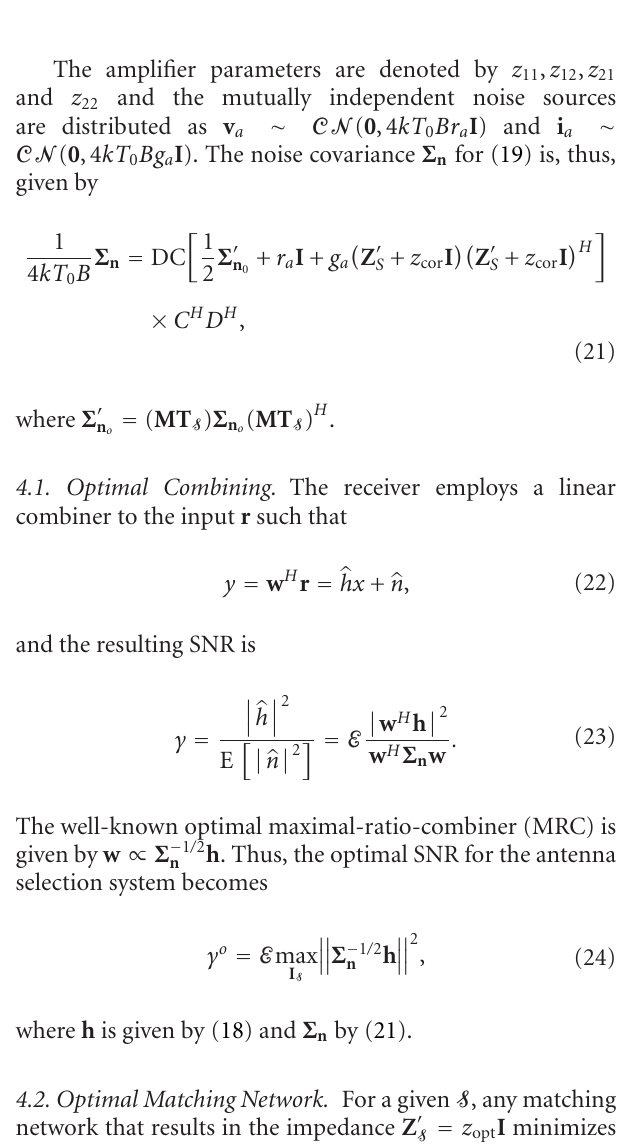
Figure 3: Circuit model of the antenna array and switching